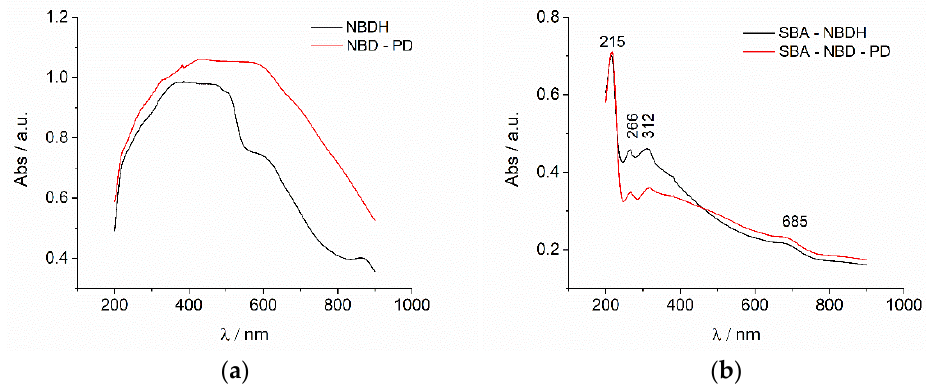
Figure 7. Thermogravimetric analyses ( a ) and differential thermogravimetric analyses (dTG) ( b ) of the pristine and functionalized SBA-15 matrices.